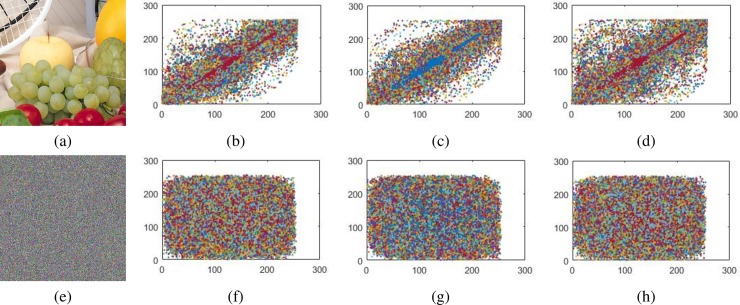
Correlation coefficient between pixel pairs for original and encrypted Fruit image.(a) Plain Fruit image. (b) Horizontal correlation. (c) Vertical correlation. (d) Diagonal correlation. (e) Encrypted Fruit image. (f) Encrypted Horizontal correlation. (g) Encrypted Vertical correlation. (h) Encrypted Diagonal correlation.